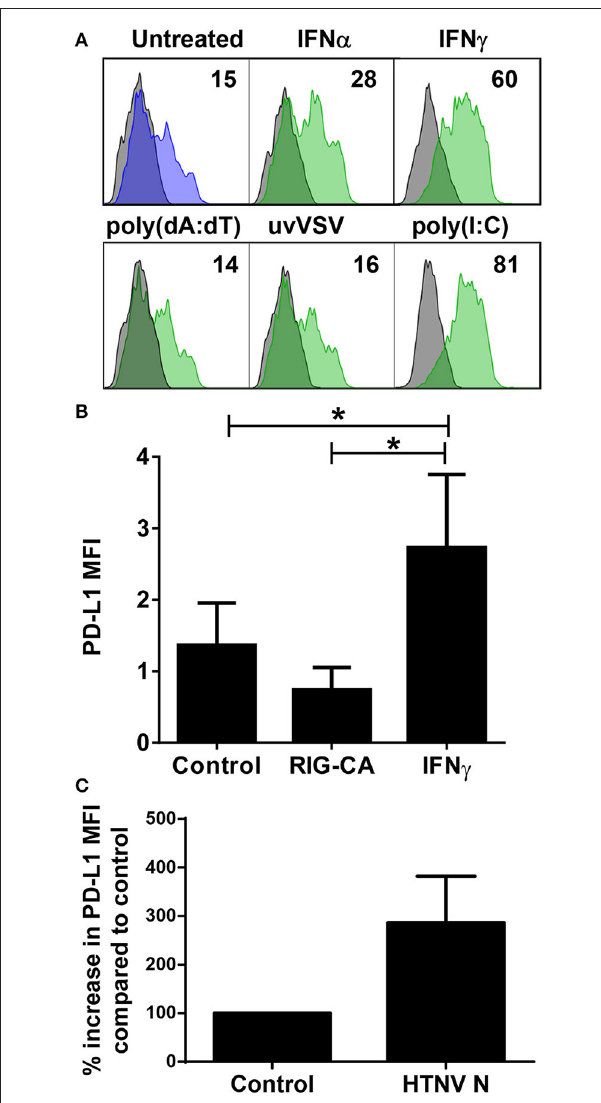
FIGURE 5 | Control of PD-L1 expression by inflammatory stimuli. (A) Immature DCs were exposed to the following inflammatory stimuli before staining for PD-L1: type I IFN (IFN- α at 1,000 U/ml), type II IFN (IFN- γ at 1,000 U/ml), poly(dA:dT), UV-inactivated VSV or poly(I:C) for 24h. The results shown are representative of three independent experiments using three different donors. (B) Huh7.5 cells (control), Huh7.5 cells permanently expressing a constitutively active form of RIG-I (RIG-CA) or Huh7.5 cells stimulated with IFN- γ at 1,000 U/ml for 24h were stained for PD-L1 and analyzed by flow cytometry. Results are derived from three independent experiments, error bars represent the mean ± SEM (* p < 0.05, paired Student’s t-test). (C) HEL cells were transfected with HTNV N-expressing plasmids or empty plasmids (Control). After 2 days cells were stained for PD-L1. Results are given as a percentage of control and are derived from three independent experiments, error bars represent the mean ± SD.